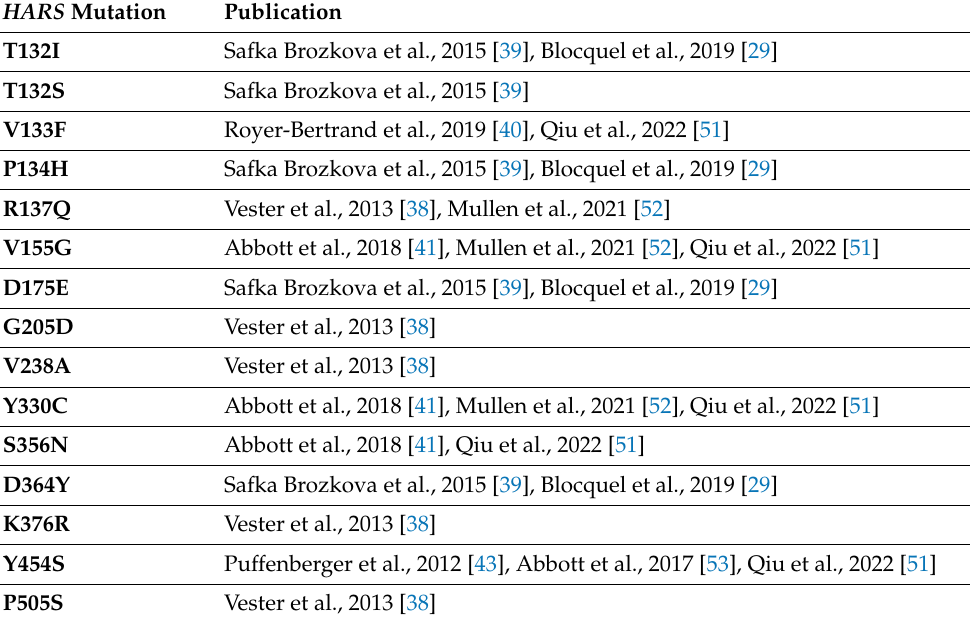
Table 1. Disease-causing mutations in human HARS